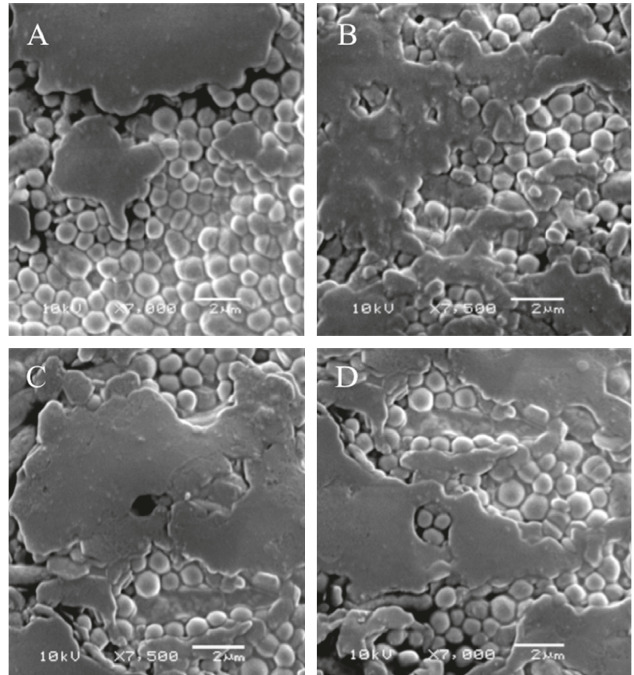
Figure 4: Scanning electron photomicrograph of biofilms of Staphylococcus aureus isolates from food contact surfaces. Biofilms were developed on SS by 8 days of incubation in TSB with 0.5% glucose at 25 ° C: (A) S. aureus 4E; (B) S. aureus 9; (C) S. aureus 13; (D) S. aureus 19. Bar � 2 μ